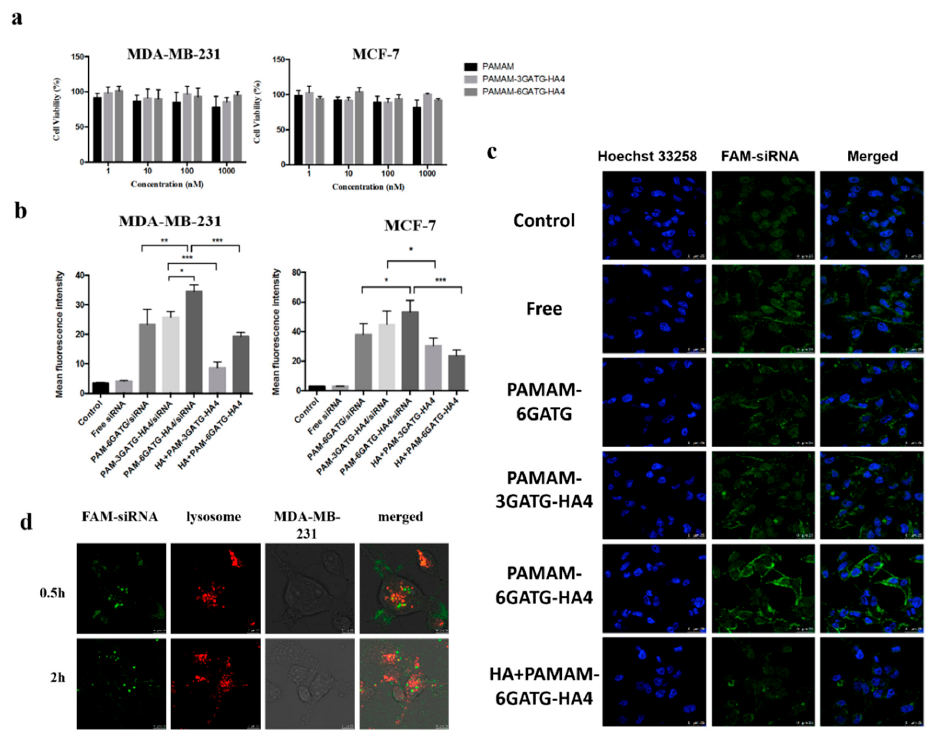
Figure 3. ( a ) Effects of vectors PAMAM, PAMAM-3GATG-HA4 and PAMAM-6GATG-HA4 on